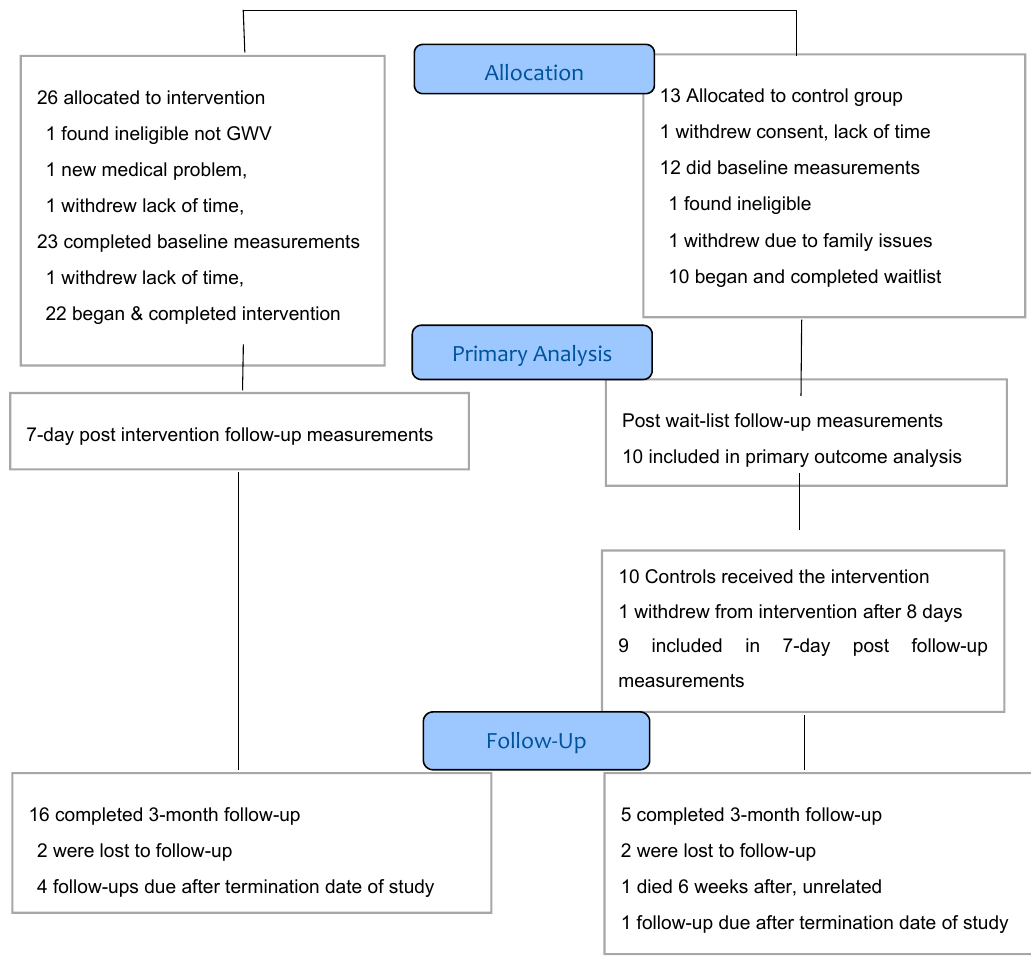
Figure 2. CONSORT Flow diagram.